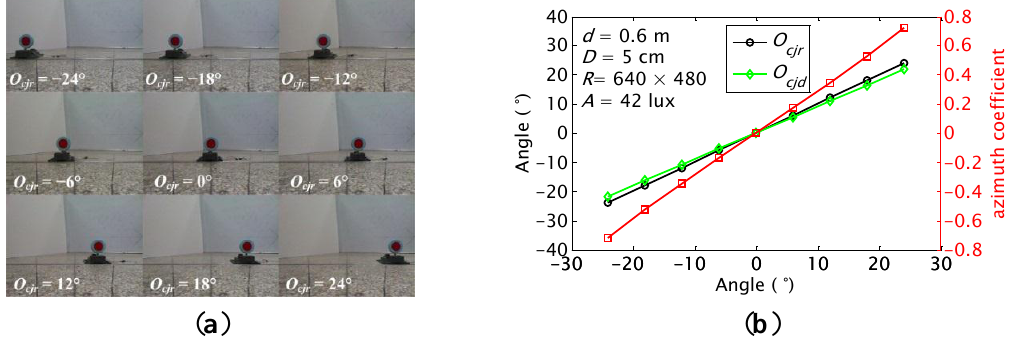
Figure 13. Azimuth coefficient and orientations detection results of the carrier at different real orientations when the distance d is 0.6 m: ( a ) recorded images; ( b ) calculated ζ and O cj